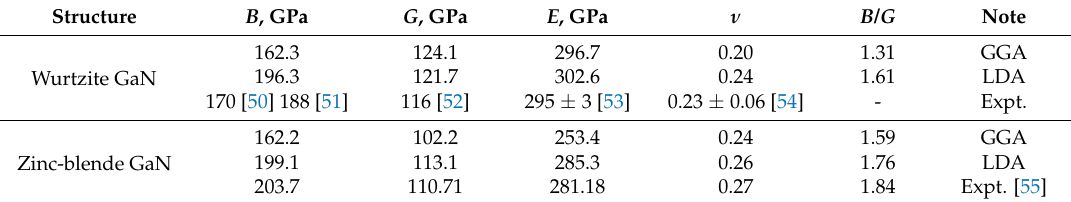
Table 4. Bulk modulus B , shear modulus G , elastic modulus E , Poisson’s ratio ν and B / G of polycrystalline GaN.